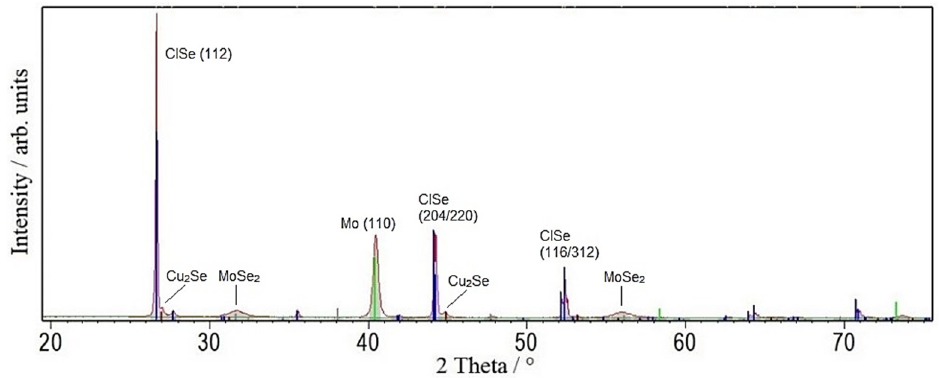
Figure 4. XRD pattern of a CISe‐film from Cu‐In + Se nanoparticle precursor with a sputter‐deposited seeding layer after face‐to‐face annealing at 550 °C for 5 min with 46.1 kN/m² pressure.